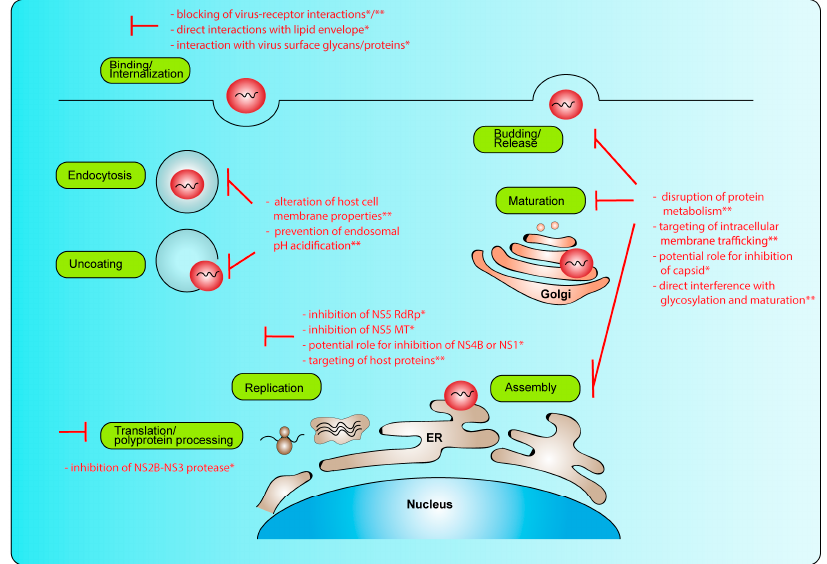
Figure 1. Intervention strategies to interfere with the different stages of the viral replication cycle. (*) direct-acting antivirals; (**) host-targeting antiviral intervention strategies. RdRp: RNA-dependent RNA polymerase, MT: methyltransferase.